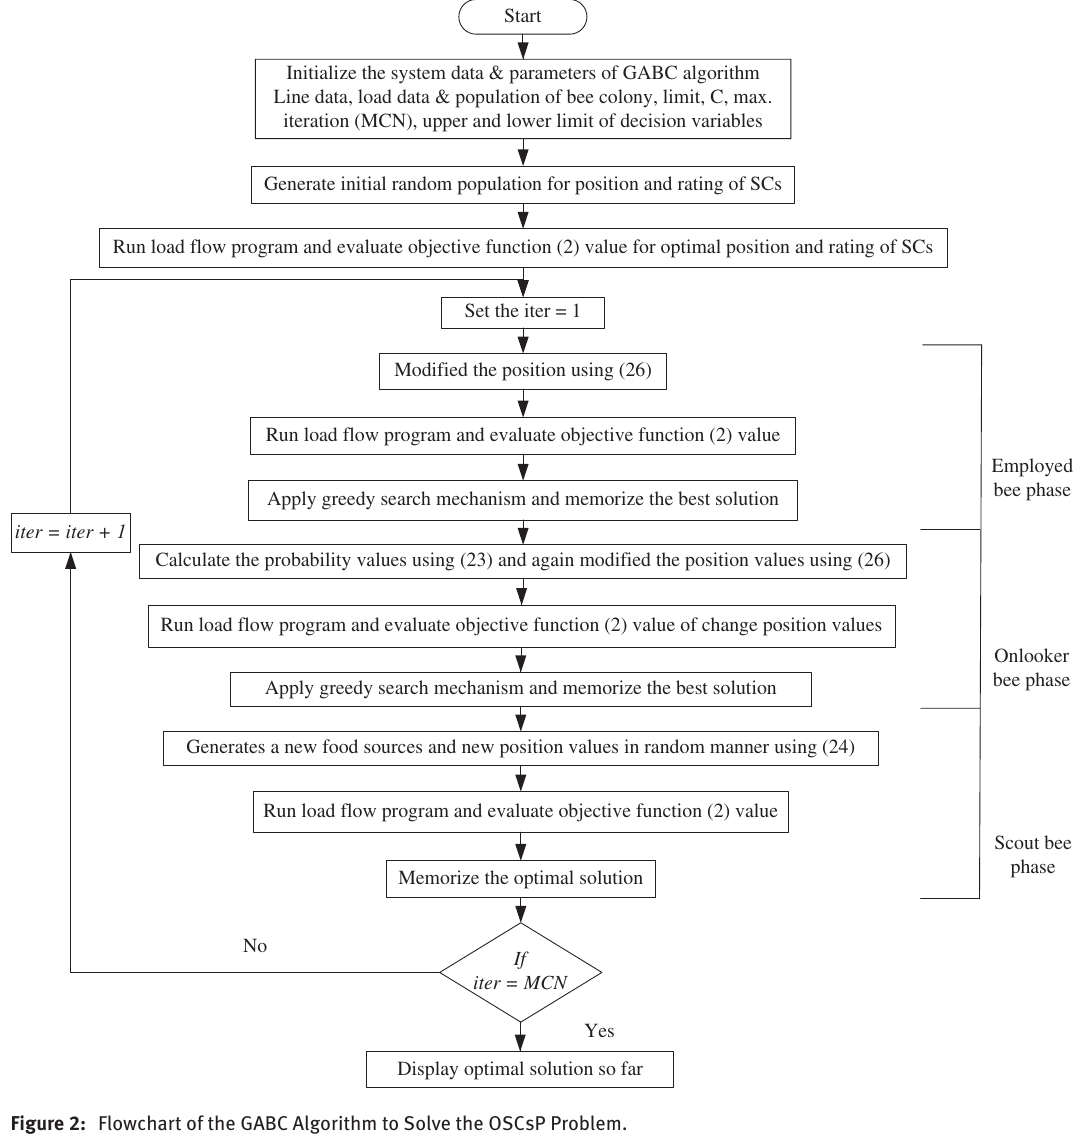
Figure 2: Flowchart of the GABC Algorithm to Solve the OSCsP